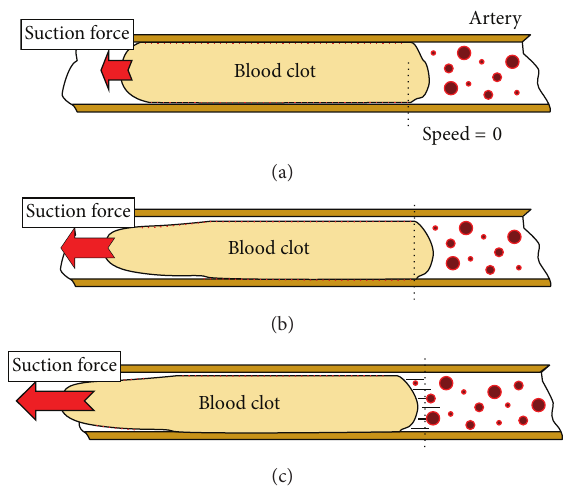
Figure 5: Influence of the suction force over blood clot. (a) The lowest value; no movement. (b) Medium value; beginning of the front part movement. (c) Higher value; blood clot